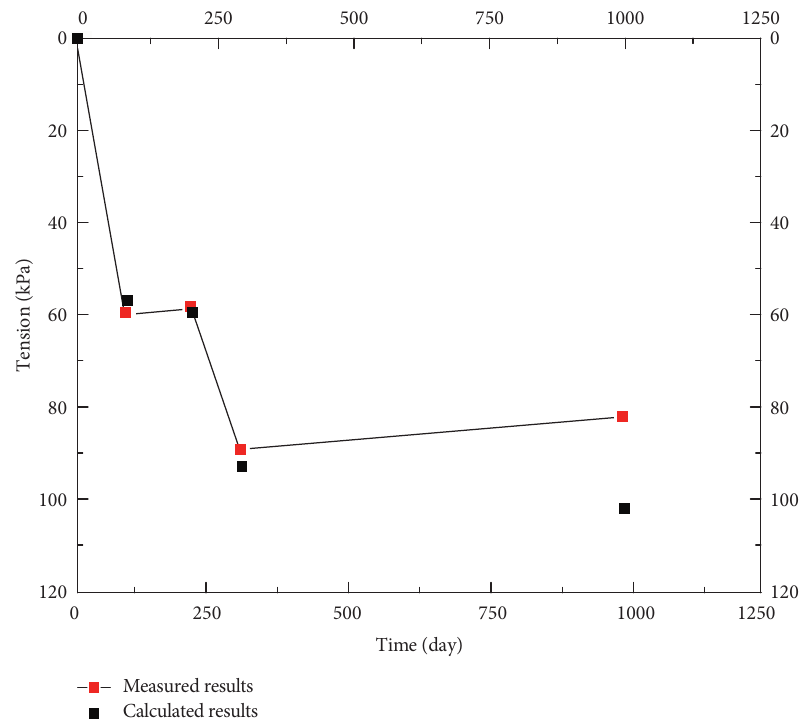
Figure 5: Measured and calculated tensile stress at the base of the